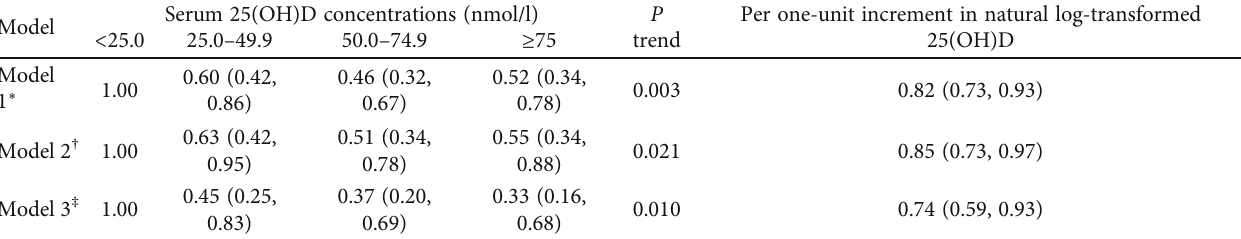
Table 2: HR (95% CIs) for all-cause mortality according to serum 25(OH)D concentrations among patients with DKD in NHANES 2001 –